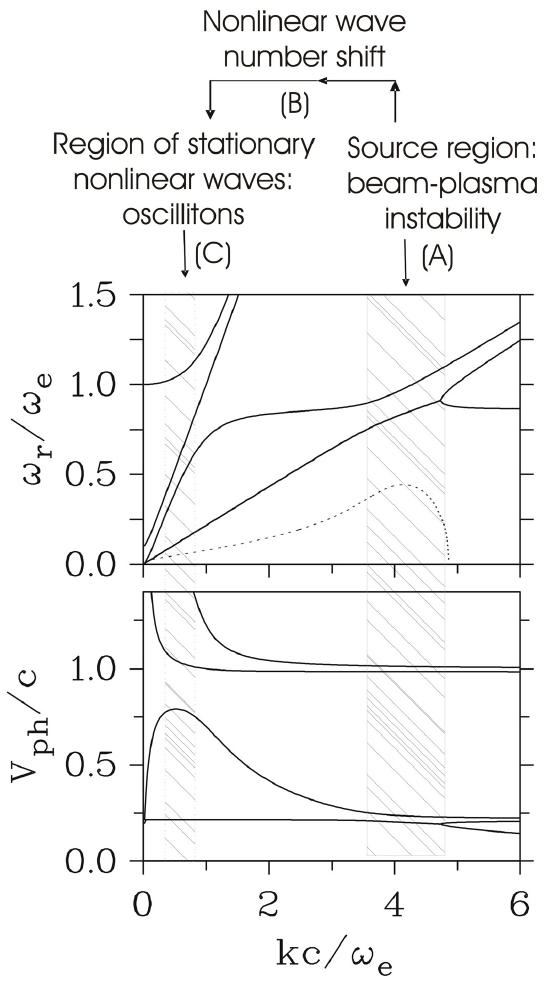
Fig. 15. From beam-plasma instability to oscillitons, different steps in the generation of plasma radiation under auroral condi- tions, (cid:127) e >ω e (schematic view). The beam-plasma instability gen- erates predominately electrostatic waves in the wave number range of kc/ω e ∼ c/V b (cid:29) 1, where V b is the beam speed. After its sat- uration a nonlinear wave number shift to small values takes place. Finally, the wave energy accumulates around the point of maximum phase velocity (Gendrin point) which ends with the formation of whistler-Langmuir oscillitons at kc/ω e ≤ 1.